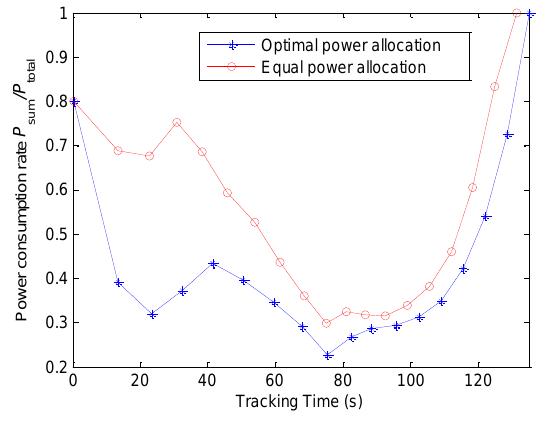
Figure 6. Power resource consumption rate.